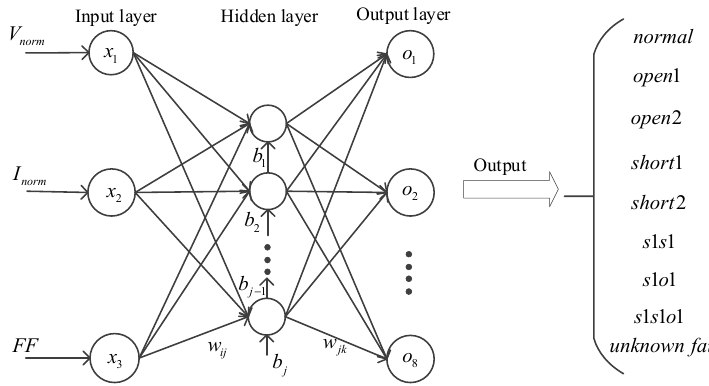
Figure 11. Basic structure of the BP neural network.